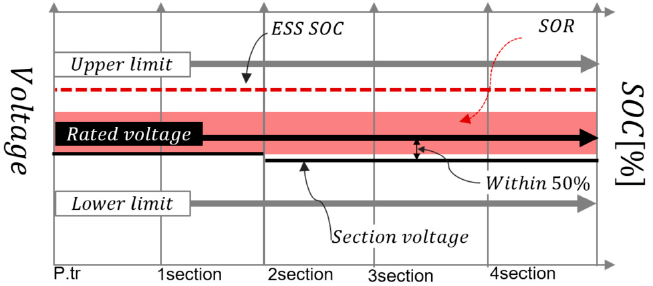
Figure 11. State of charge (SOC) operation of ESS within the state of reference (SOR).